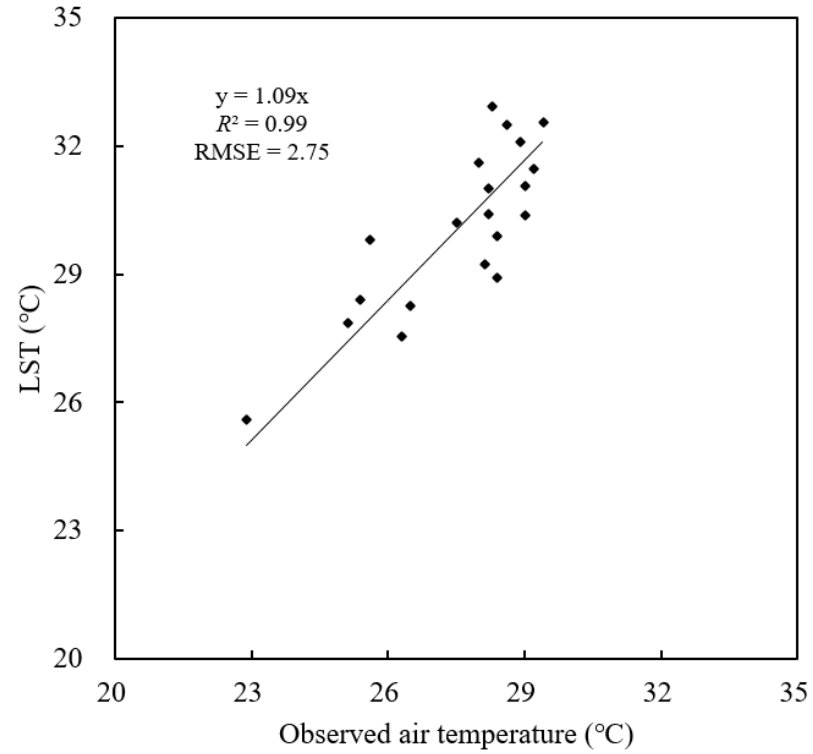
Figure 4. Relationship between observed air temperature and retrieved LST.